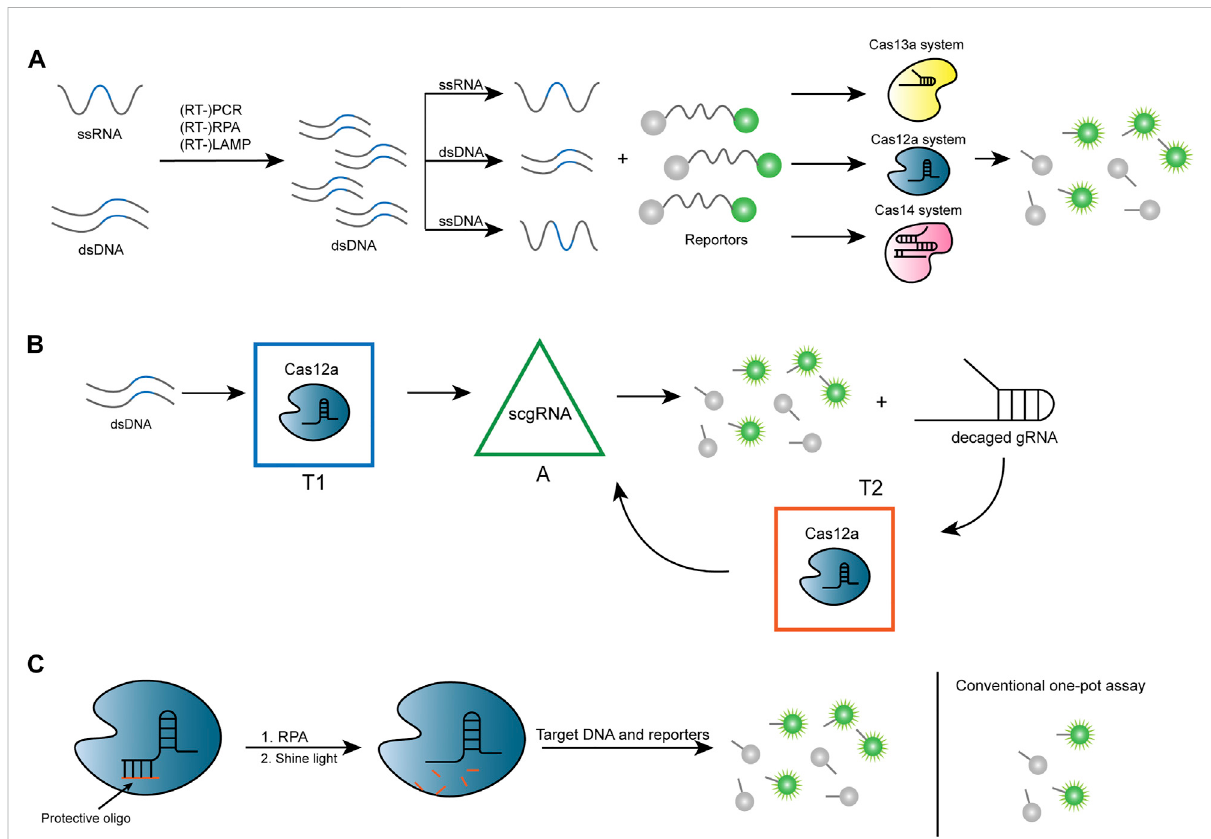
FIGURE 3 Strategies for Cas12 and Cas13-based nucleic acid sensor. (A) After ampli fi cation, ssRNA or dsDNA forms dsDNA and produces ssRNA, dsDNA, and ssRNA, depending on the different systems. After being mixed with fl uorescent reporters, trans cleavage occurs through speci fi c binding of different CRISPR/Cas systems, which subsequently generates a fl uorescent signal. (B) In CONAN, there are three signal processors, namely transducer1(T1),transducer2(T2), and signalampli fi er (A),where theparallelconnection ofAandT2formsapositive feedback circuitand T1is connected in series with the positive feedback circuit. Cas12a and gRNA for target dsDNA (gRNA-T) are pre-assembled as T1, which converts the signal input into active Cas12a protein (Cas12a/gRNA-T/DNA complex). After the action of a self-reporting scgRNA, an ampli fi ed fl uorescent signal and multiple active (decaged) gRNA molecules are output. T2 contains Cas12a protein and a probe for decaged gRNA, which can transduce the resulting decaged gRNA into another active Cas12a protein to produce an ampli fi ed fl uorescent signal. scgRNA: switchable-caged guide RNA. (C) The protective oligonucleotide is designed to partially pair with the crRNA, thereby altering the conformation of the crRNA so that it cannot bind to the target DNA and inhibit the cleavage activity of Cas12a. The protective oligonucleotide breaks when exposed to ultraviolet (UV) light at 365 nm isolated from crRNA, thereby restoring the function of CRISPR-Cas12a detection. This system ensures that the target DNA is not reduced by Cas12a during the ampli fi cation phase, resulting in a stronger fl uorescent